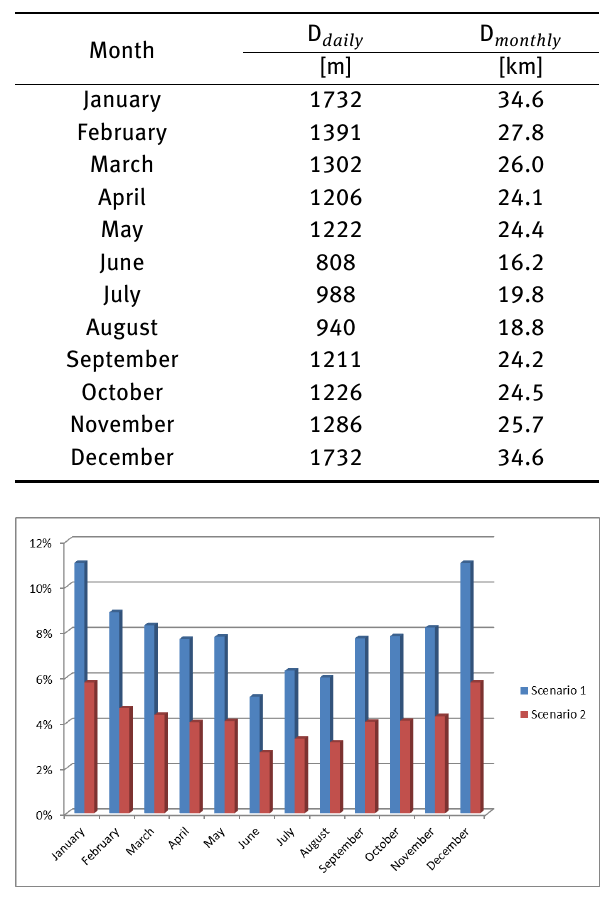
Figure 8: Gasoline mileage share in the total mileage of a vehicle equipped with an LPG